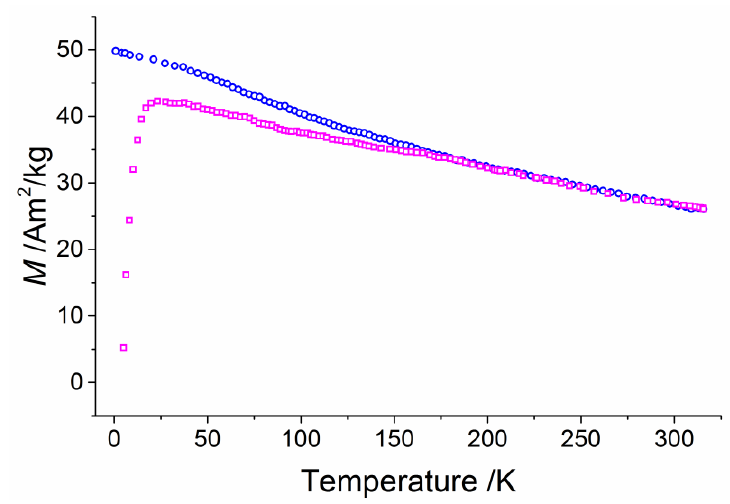
Figure 5. Magnetization of the fabricated SFMO nanoparticles in the FC mode (blue dots) and in the ZFC mode (magenta squares).